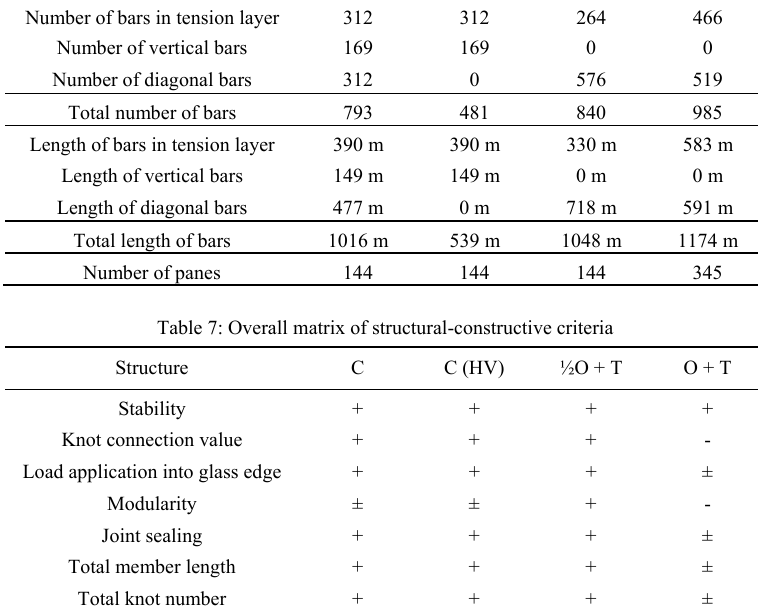
Table 6: Length and number of bars and panes of the structures Structure